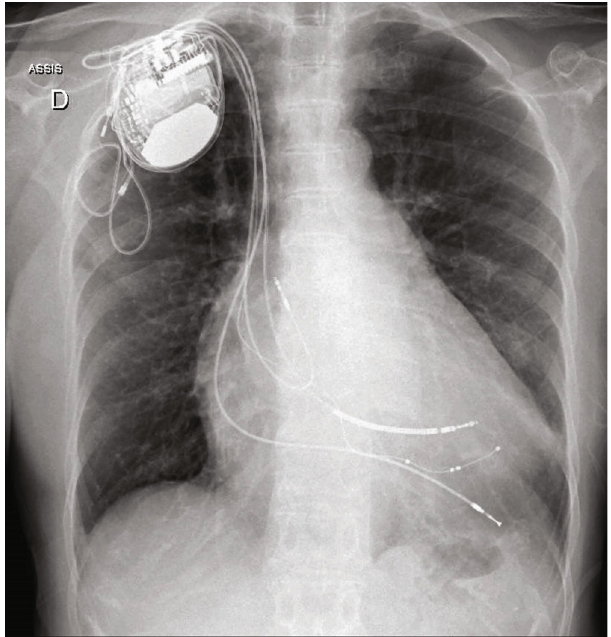
Figure 4: Anteroposterior fl uoroscopic view showing the fi nal placement of the leads and of the